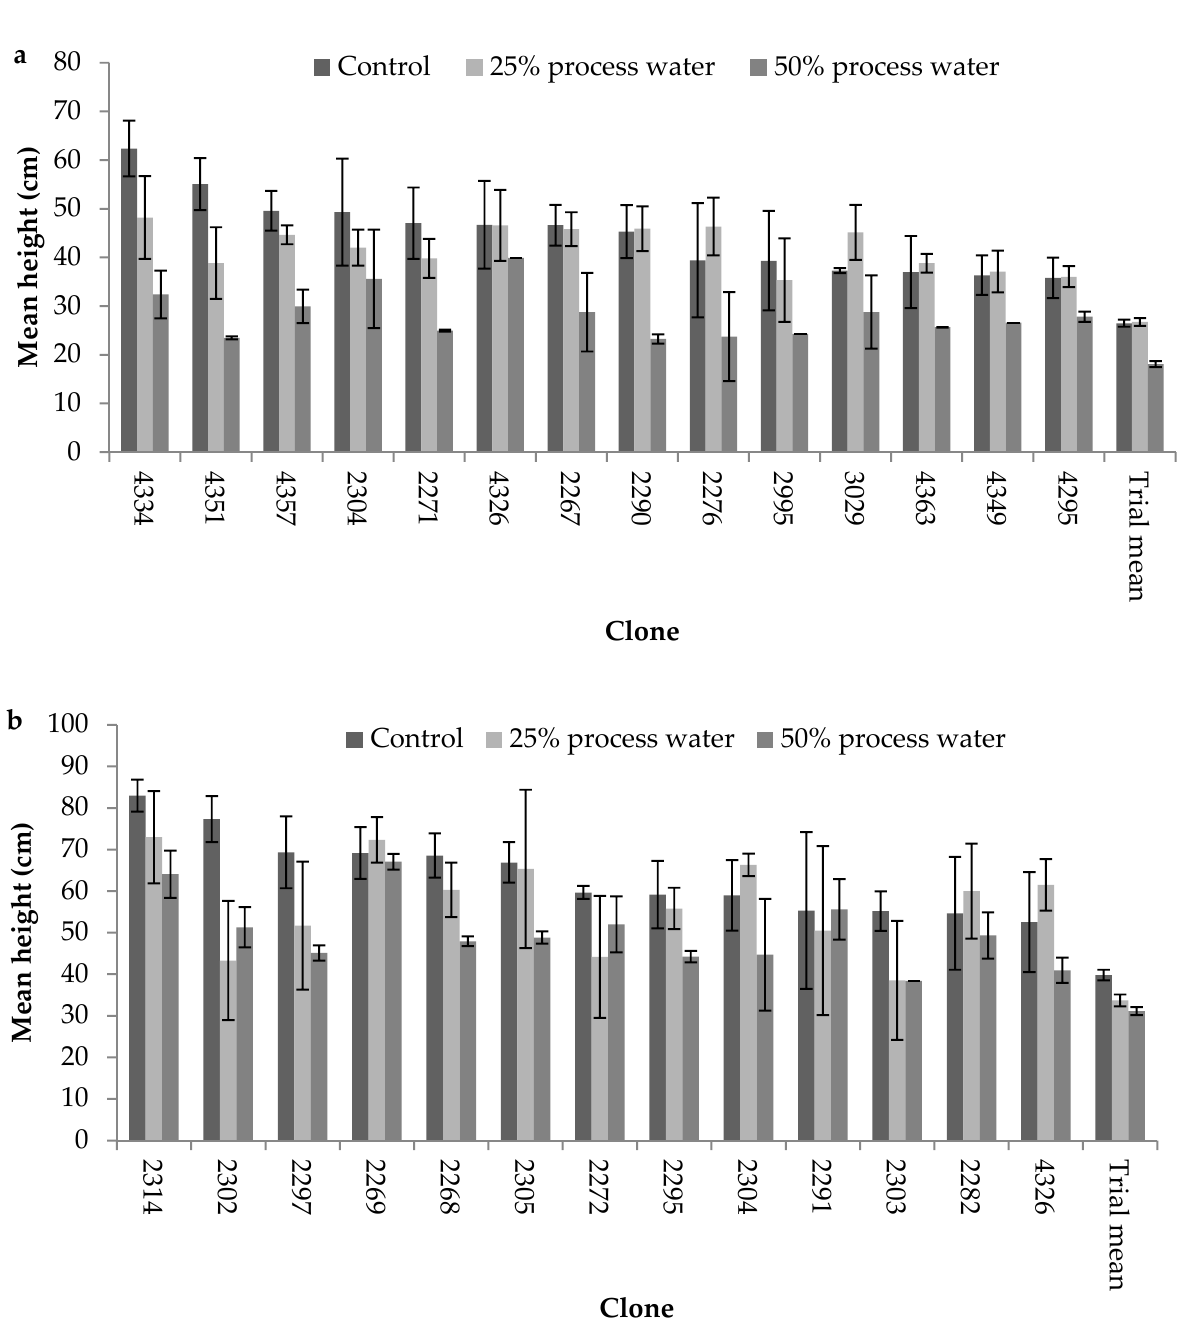
Figure 1. ( a ) Mean height ( ± SE) of 14 balsam poplar clones that ranked in the top 30 for all three water treatments as compared with the overall trial mean for 148 clones after 44 days of growth in the 2012 experiment. ( b ) Mean height ( ± SE) of 13 balsam poplar clones that ranked in the top 30 for all three water treatments as compared with the overall trial mean for 86 clones after 65 days of growth in the 2013 experiment.